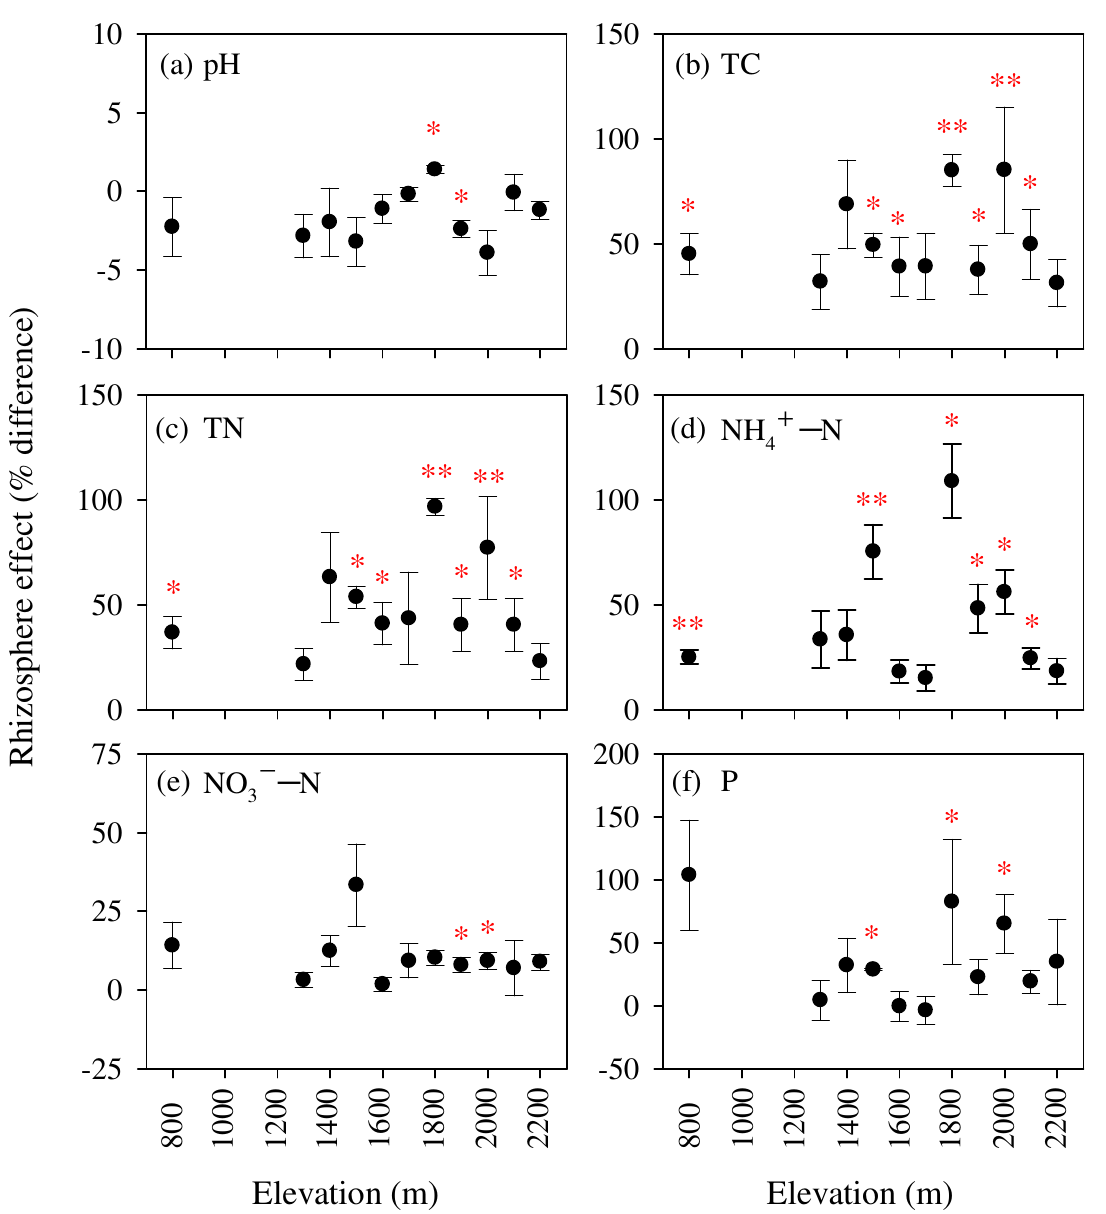
Figure 4. Relationship of the rhizosphere effects on soil pH value (pH, ( a )), total carbon (TC, ( b )), total nitrogen (TN, ( c )), ammonium nitrogen (NH + −N, ( d )), nitrate nitrogen (NO - −N, ( e )) and extractable phosphorous (P, ( f )) with elevation. There was no significant linear regression ( p > 0.05). For each elevation, values are the means and error bars are the standard errors of replicated plots ( n = 4). Asterisks indicate significant differences between rhizosphere soil and bulk soil based on paired−samples t −tests (* p < 0.05 and ** p < 0.01).